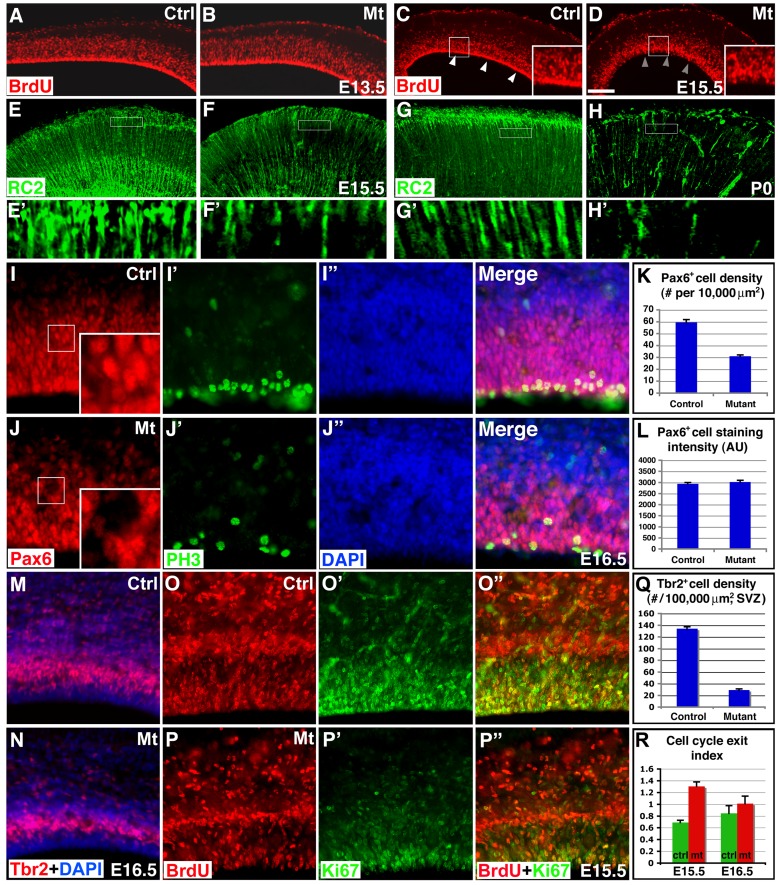
Blockade of cell cycle progression reduces cortical neural progenitors without affecting cell fate.(A–D) Effects of orc3 deletion on radial glial division. BrdU labeling (in red) revealed no obvious defects in ventricular zone division at E13.5, but substantial reductions at E15.5, especially at the ventricular surface (arrowheads in C and D). (E–H) Effects of orc3 deletion on radial glial density. RC2 staining (in green) revealed substantial reductions in radial glial density at E15.5 and near complete loss at P0. Boxed areas in (E–H) are shown in (E′–H′). Also notice more severe loss of radial glia in the mutant medial cortex (right side in H). (I–J″) Effects of orc3 deletion on radial glial fate. Although reduced in number, mutant radial glia express normal levels of Pax6 (in red) (I and J) at E16.5. PH3 (in green) staining also revealed a reduced number of mitotic cells at the ventricular surface (I′ and J′). (K–L) Quantification of Pax6+ cell density and expression level. Significant differences were observed in Pax6+ cell density (p = 0.0003, n = 4) but not Pax6 staining intensity (p = 0.32, n = 20). Note cells are less densely packed in mutants. (M–N) Effects of orc3 deletion on intermediate progenitors. Tbr2 staining (red) revealed severe reduction in intermediate progenitors in mutants at E16.5. (O–P″) Cell cycle exit analysis at E15.5. BrdU was administered at E14.5 followed by staining for BrdU (red in O, P, O″, and P″) and Ki67 (green in O′, P′, O″, and P″) at E15.5. (Q) Quantification of Tbr2+ cells in the subventricular zone at E16.5. Significant reductions were observed in mutants at E16.5 (p = 3×10−15, n = 9). (R) Cell cycle exit indices at E15.5 and E16.5. Significant increases were observed in mutants at E15.5 (p = 0.0001, n = 5), but not at E16.5 (p = 0.39, n = 5). Scale bar (in D): 200 µm for (A–D), 50 for µm for (E–H), and 60 µm for (I–J″) and (M–P″).